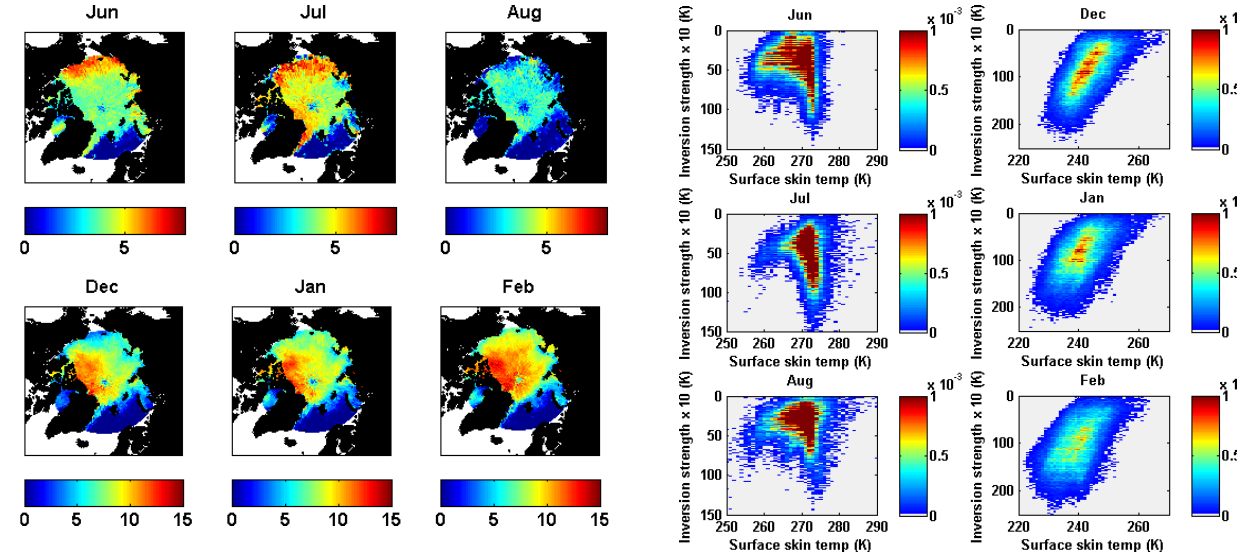
Fig. 6. The joint histograms of inversion strength and surface temperature for summer (left column) and winter (right column) months. Note that the X and Y axes are different for summer and winter months and inversion strength is multiplied by 10. Each temperature-temperature bin is normalized by the total number of observations in the entire